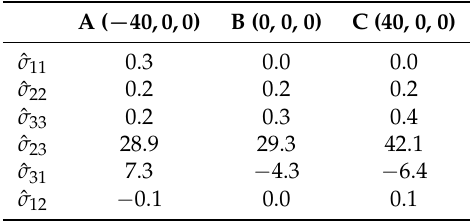
]] (MPa) and [[ ω e ]] ( ◦ ) given by the FE ∼ ∼